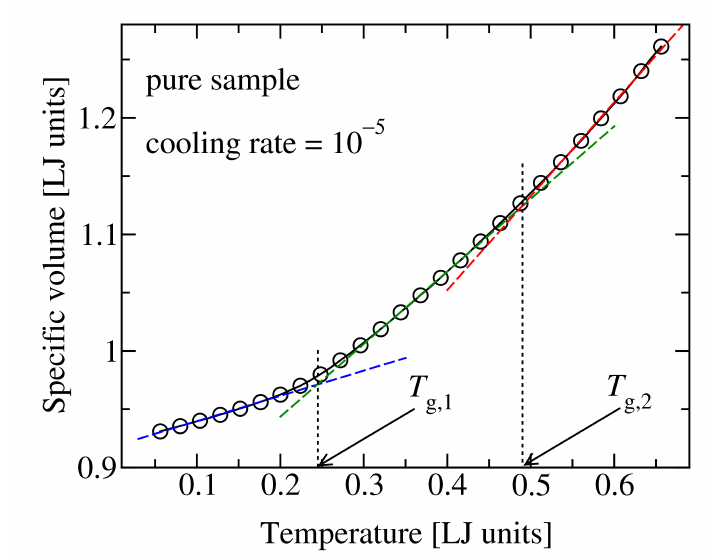
Figure 3. Specific volume, ν = V / N p , versus temperature at a fixed pressure of p = 0 for a constant cooling rate of ˙ T = 10 − 5 . Bending of the curve signals glass transition. Here, a distinct kink is identified at low temperatures ( T ∈ [ 0.2,0.3 ] ). The intersection of linear segments determines the corresponding glass transition temperature (here T g,1 ≈ 0.25). A close scrutiny of the data at higher temperatures ( T > 0.4) reveals a further, albeit much weaker change of slope. The associated glass transition is more difficult to determine from simulated data. Here we estimate a value of T g,2 ≈ 0.49. All quantities are given in reduced Lennard-Jones